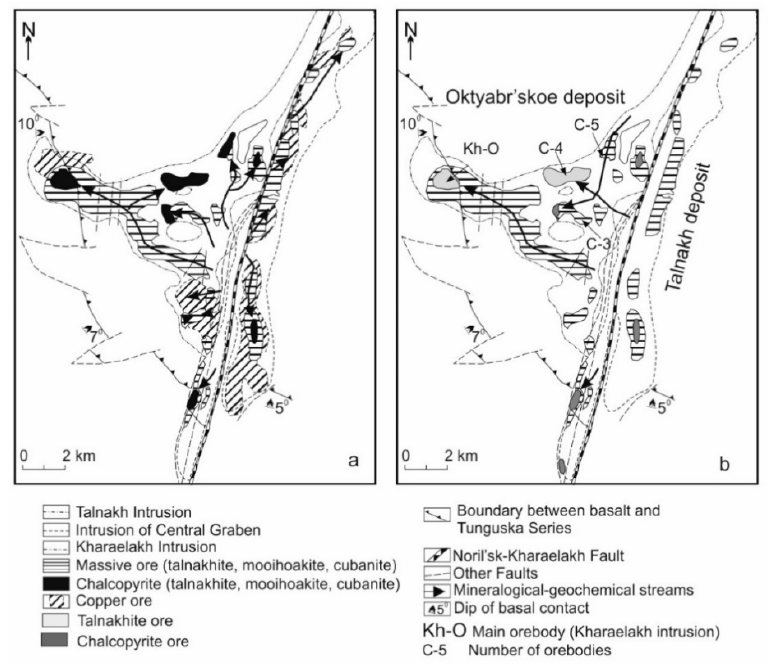
Figure 14. Projection on the surface of the Kharaelakh and Talnakh intrusions and massive ores: ( a ) after [27], ( b ) with authors data and interpretation.